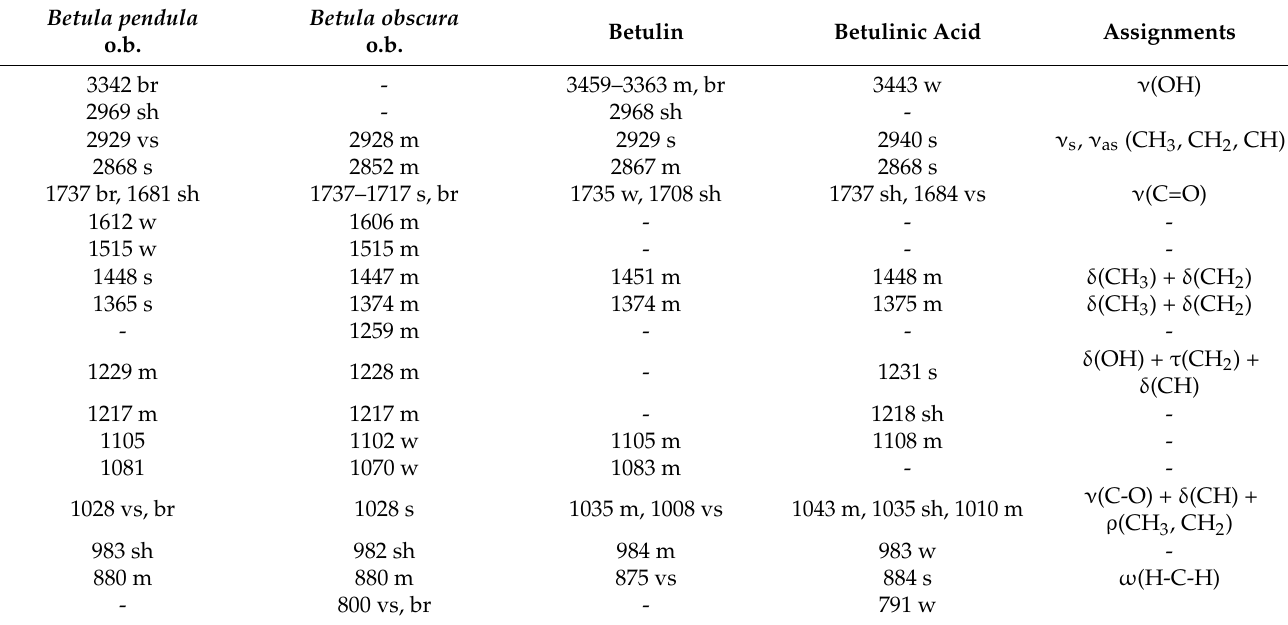
Table 1. Vibrational frequencies (cm − 1 ) with assignments of B. pendula and B. obscura outer bark extracts and reference standards of betulin and betulinic acid.